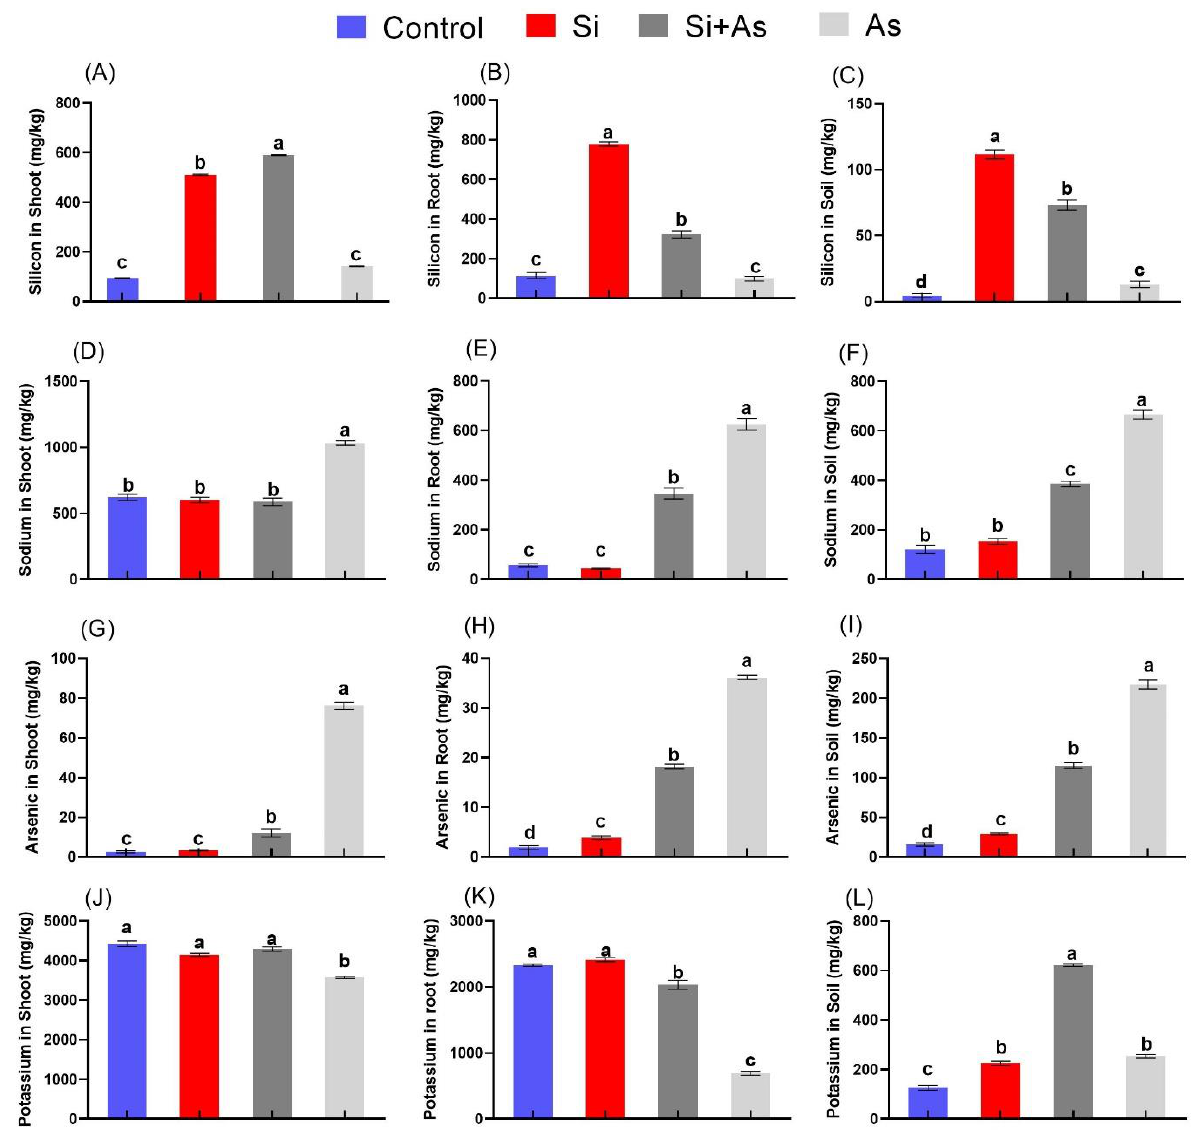
Figure 11. Elemental analysis of silicon (Si), arsenic (As) exogenously applied, and essential nutrients levels determinations via ICP in date palm. Means for all respective treatments were used to determine significant difference ( p > 0.05) via by Duncan’s multiple range test (DMRT). Symbols show significant difference and values represent mean (of 4 replicates) ± standard error.